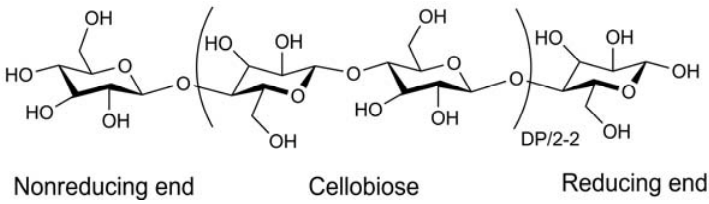
Figure 1. Molecular structure of cellulose.